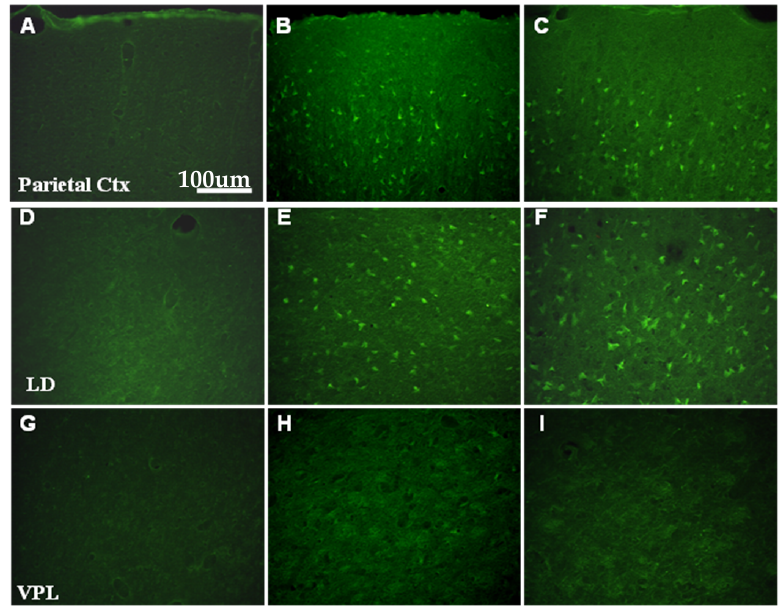
Figure 5. The plate illustrates FluoroJade B (FJB) staining of neurons, indicative of ongoing neuronal degeneration, 6 h ( B , E , H ) and 24 h ( C , F , I ) after the onset of pilocarpine-induced seizures lasting 3 h. No FJB-stained cells are evident in the control animals ( A , D , G ). Note the occurrence of numerous FJB-positive cells in regions such as the parietal cortex (Ctx in ( B , C )) and thalamic domains (laterodorsal thalamic nucleus, LD, in ( E , F )) in which the astrocytic Cx expression was seen to decrease after pilocarpine-induced status epilepticus. The thalamic ventroposterolateral nucleus (VPL in ( H , I )), in which Cx43 and Cx30 expression did not show significant variation after SE (see Figure 1), is devoid of degenerating cells.